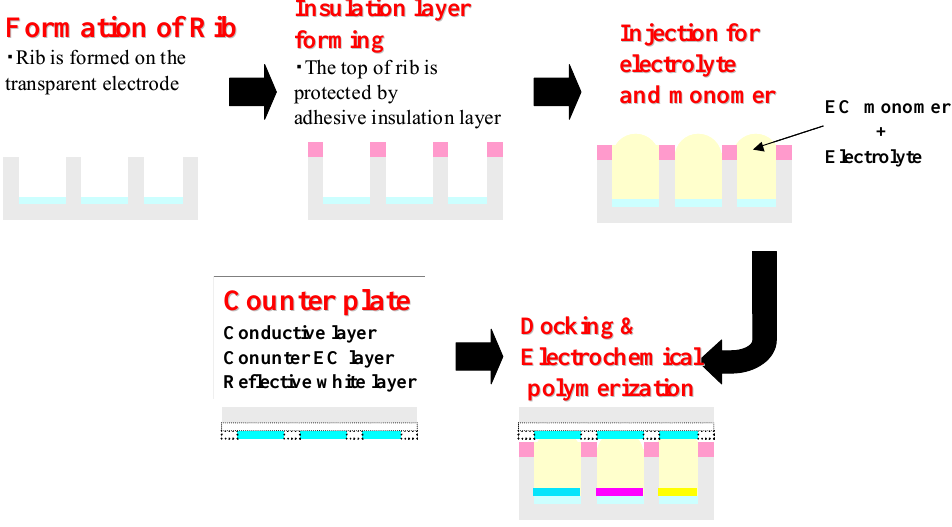
Figure 3. A fabrication process for electrochromic (EC) polymer type e-paper. Formation of RibFormation of